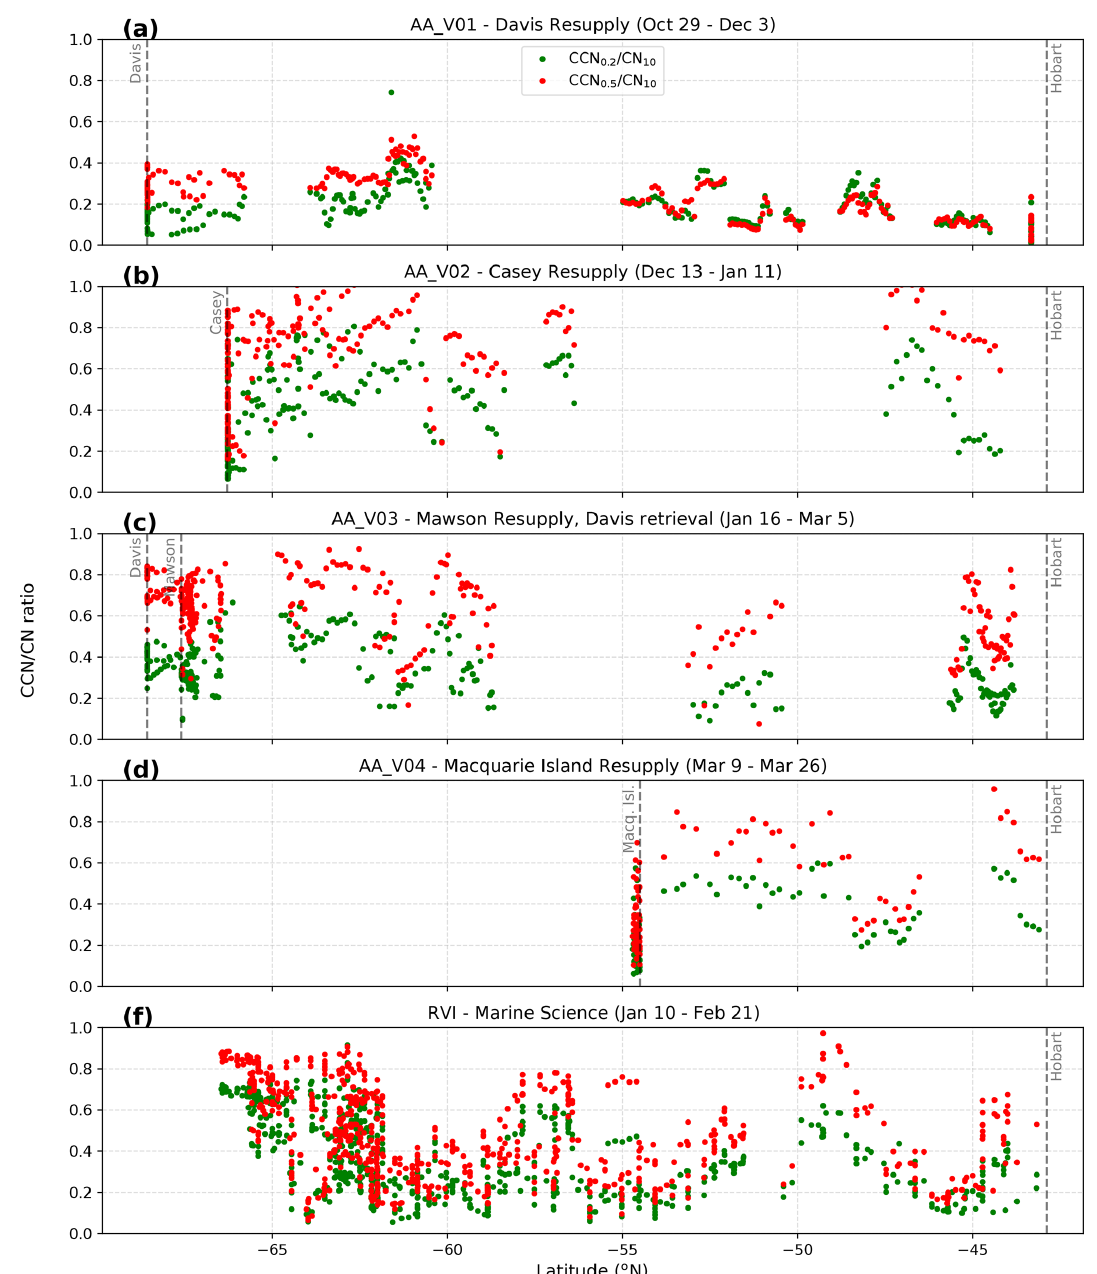
Figure A6. As in Fig. A3 but for CCN / CN 10 ratio